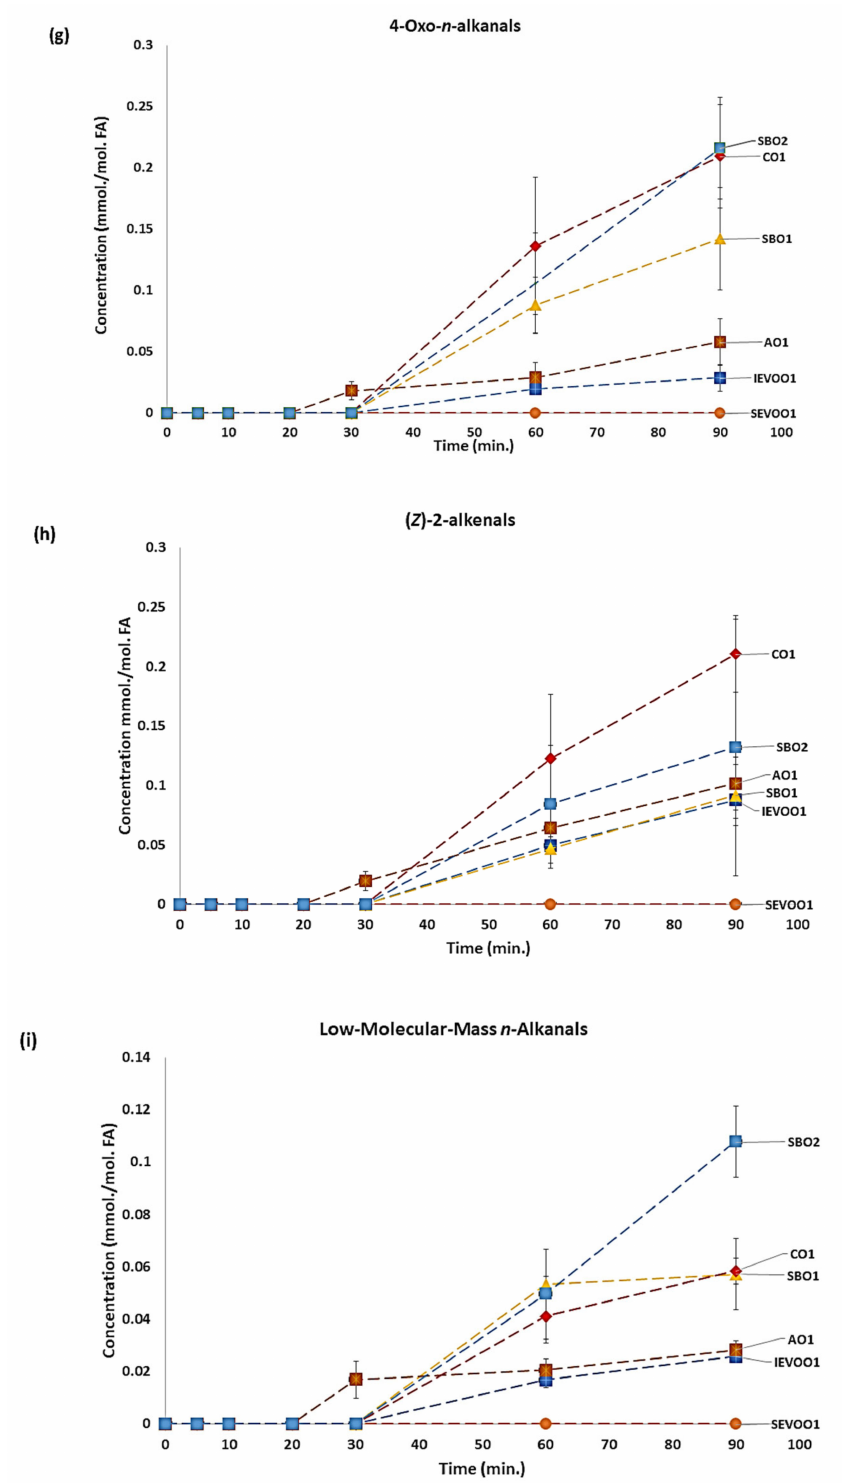
Figure 2. Plots of mean ± SEM 1 H NMR-determined aldehyde concentrations (mmol./mol. FA) for culinary oils exposed to LSSFEs at 180 o C for 0, 5, 10, 20, 30, 60 and 90 min durations ( n = 3 replicate samples for each sampled time-point for each oil product). ( a ), ( E )-2-Alkenals; ( b ), ( E,E )-Alka-2,4-dienals; ( c ), 4-5-Epoxy-( E )-2-alkenals; ( d ), 4-Hydroxy-/4-Hydroperoxy-( E )-2- alkenals; ( e ), n -Alkanals; ( f ), ( E,Z )-2-4-alkadienals; ( g ), 4-Oxo- n -alkanals; ( h ), ( Z )-2-alkenals; ( i ), Low- Molecular-Mass n -Alkanals. Oil type abbreviations: as in Section